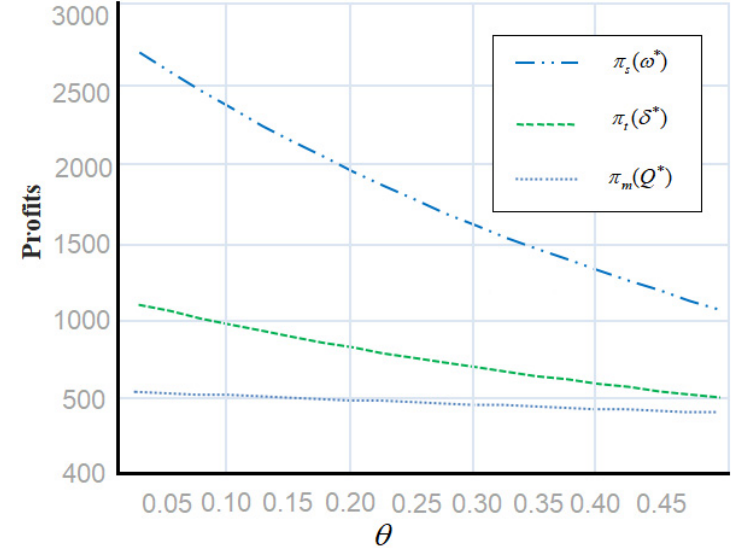
Figure 1. Impacts of θ on the profits of partners.